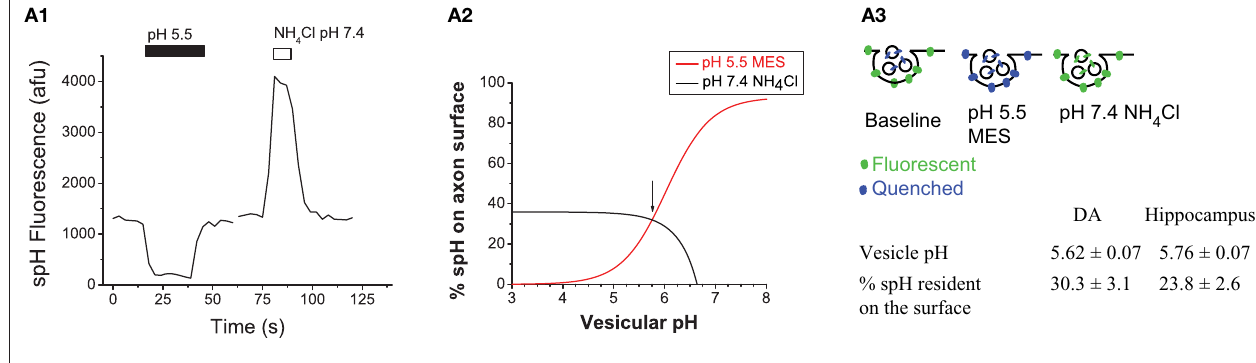
FIGURE 2 | The internal vesicle pH and synaptic distribution of spH are quenching (red) and NH Cl dequenching (black) experiments from (A1) were 4 similar between DA and hippocampal synapses. (A1) Representative used to calculate spH surface fraction, using equations described previously example of the change in spH fl uorescence at presynaptic terminals upon (Mitchell and Ryan, 2004). The two independent measurements (acid quench exposure to buffer containing 25 mM MES at pH 5.5 and 50 mM NH Cl at and NH Cl dequench) in the same set of boutons converged at the value of 32% 4 4 pH 7.4. Exposure to pH 5.5 quenches spH fl uorescence on the axon surface, surface fraction and vesicular pH of 5.75 (arrow). (A3) Similar experiments were Cl raises the intra-vesicular pH to 7.4, thereby and application of NH also conducted in hippocampal neurons and revealed that the internal vesicle pH 4 dequenching vesicular spH fl uorescence, as shown graphically in (A3) . Traces and synaptic distribution of spH are similar between DA and hippocampal represent the average from 20 boutons in a single neuron. (A2) Measurement synapses. n = 8 DA neurons and n = 6 hippocampal neurons. Data compared of surface fraction and vesicular pH. The fl uorescence changes in the pH 5.5 using Student’s t -test. Error bars are